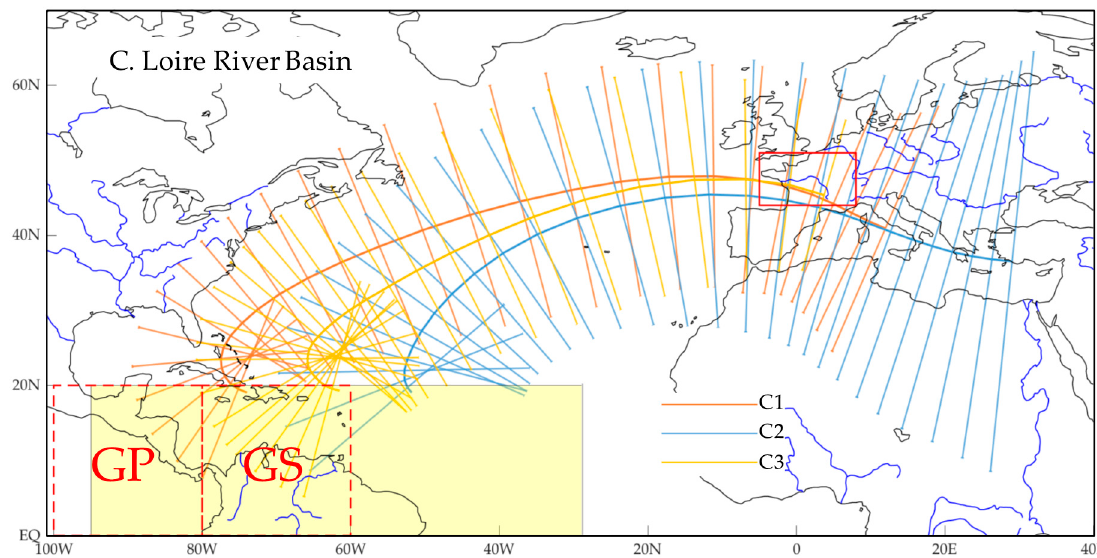
Figure 4. Trajectory clustering for the three case study basins (red box with solid lines): ( A ) the Yangtze; ( B ) the Mississippi and ( C ) the Loire. Colored lines are the average trajectories for different clusters. The bars perpendicular to the trajectory lines cover 95% of the tracks belonging to that cluster. The yellow regions are the identified major TMEs source regions. The global hotspots of TMEs moisture sources are highlighted by the boxes with dashed red lines.